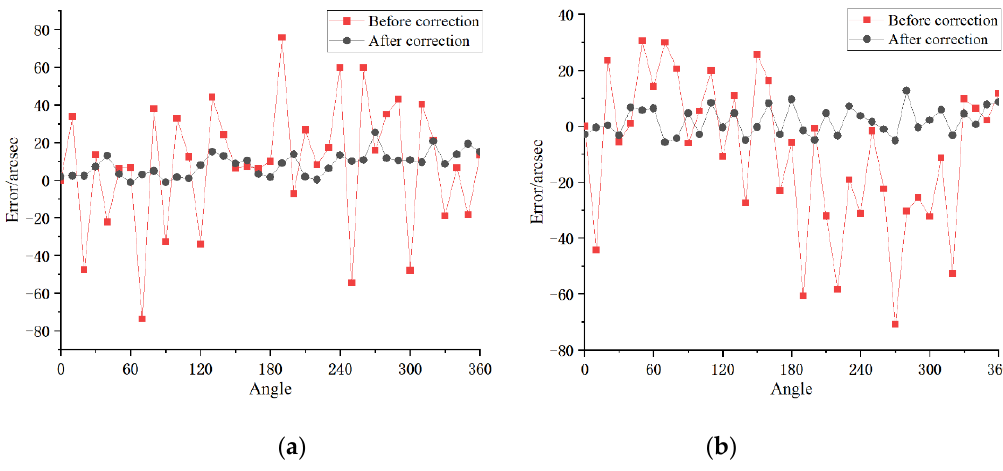
Figure 9. Before and after comparison of angle error compensation: ( a ) joint module a; ( b ) joint module b.